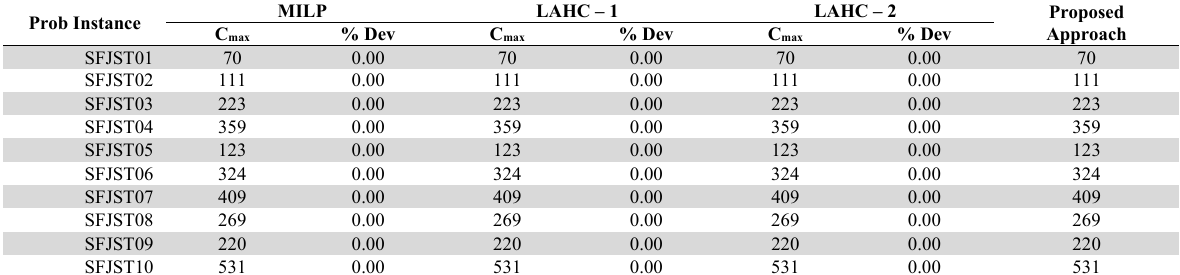
Comparison of Proposed Approach Results for Problem Set 3 (Small Sized Problems) for C max